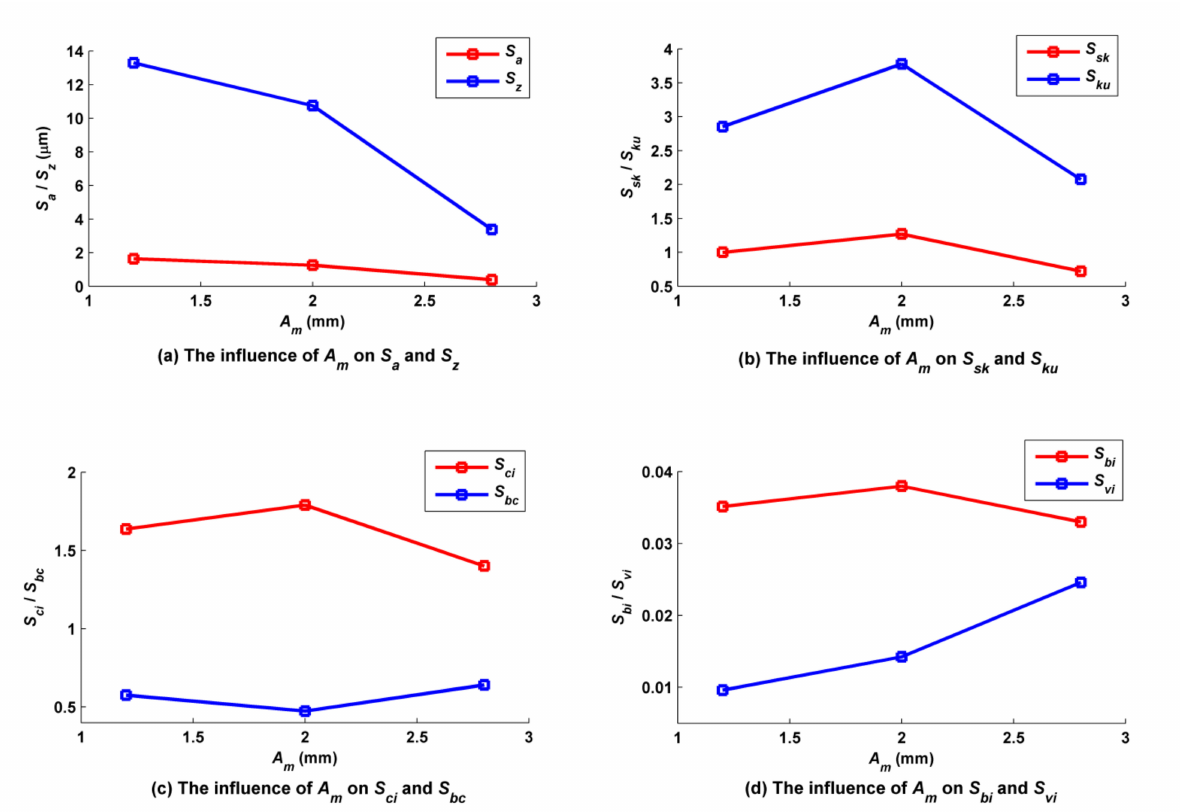
Figure 13. Influence of amplitude on ball-end trochoidal milling surface